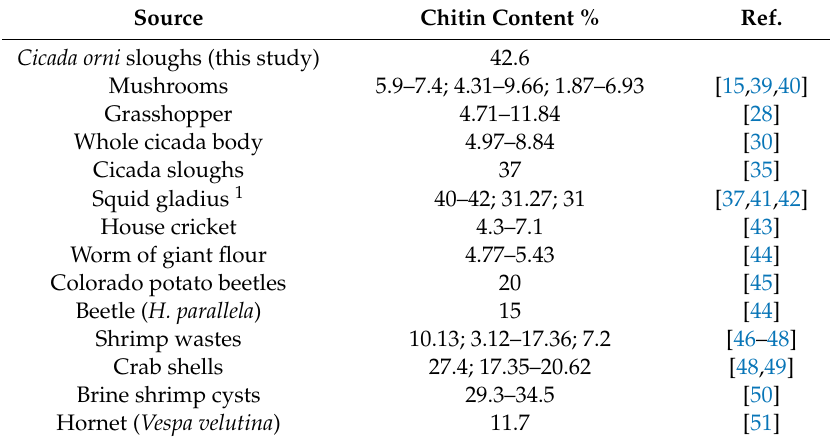
Table 1. Chitin content from di ff erent